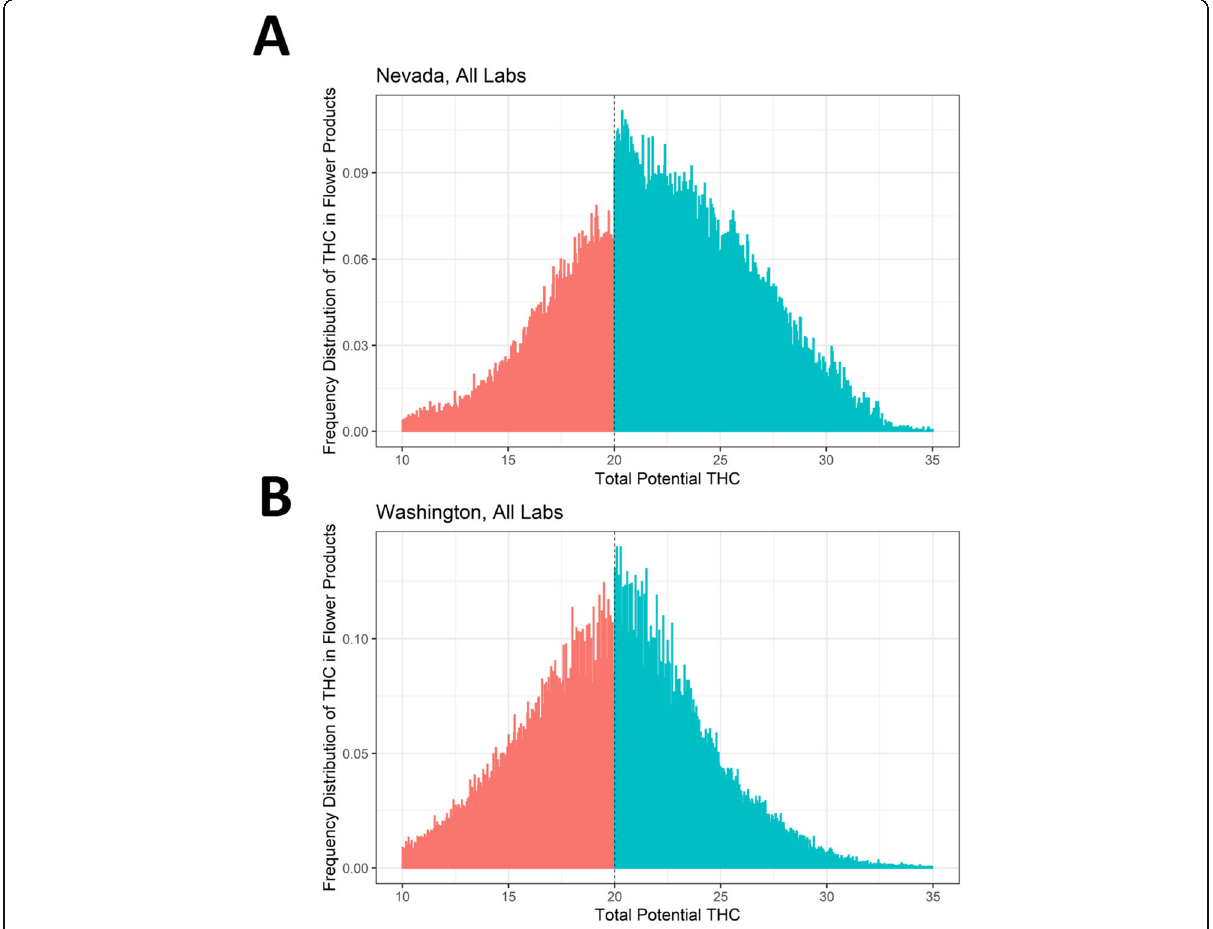
Fig. 1 Frequency of reported THC content in flower products around the 20% threshold in Nevada and Washington. This figure consists of two plots showing histograms of the frequency of reported THC, with bins to the left of the 20% threshold shaded red and bins to the right of the 20% threshold shaded blue. The top plot (panel a ) shows data from all labs in Nevada, and the bottom (panel b ) shows all labs in Washington. Both states show a spike in the frequency of products just above the 20% threshold, though the increase is larger in Nevada. Plots are left- truncated at 10% for presentational purposes. Histogram bins were generated via the DCdensity